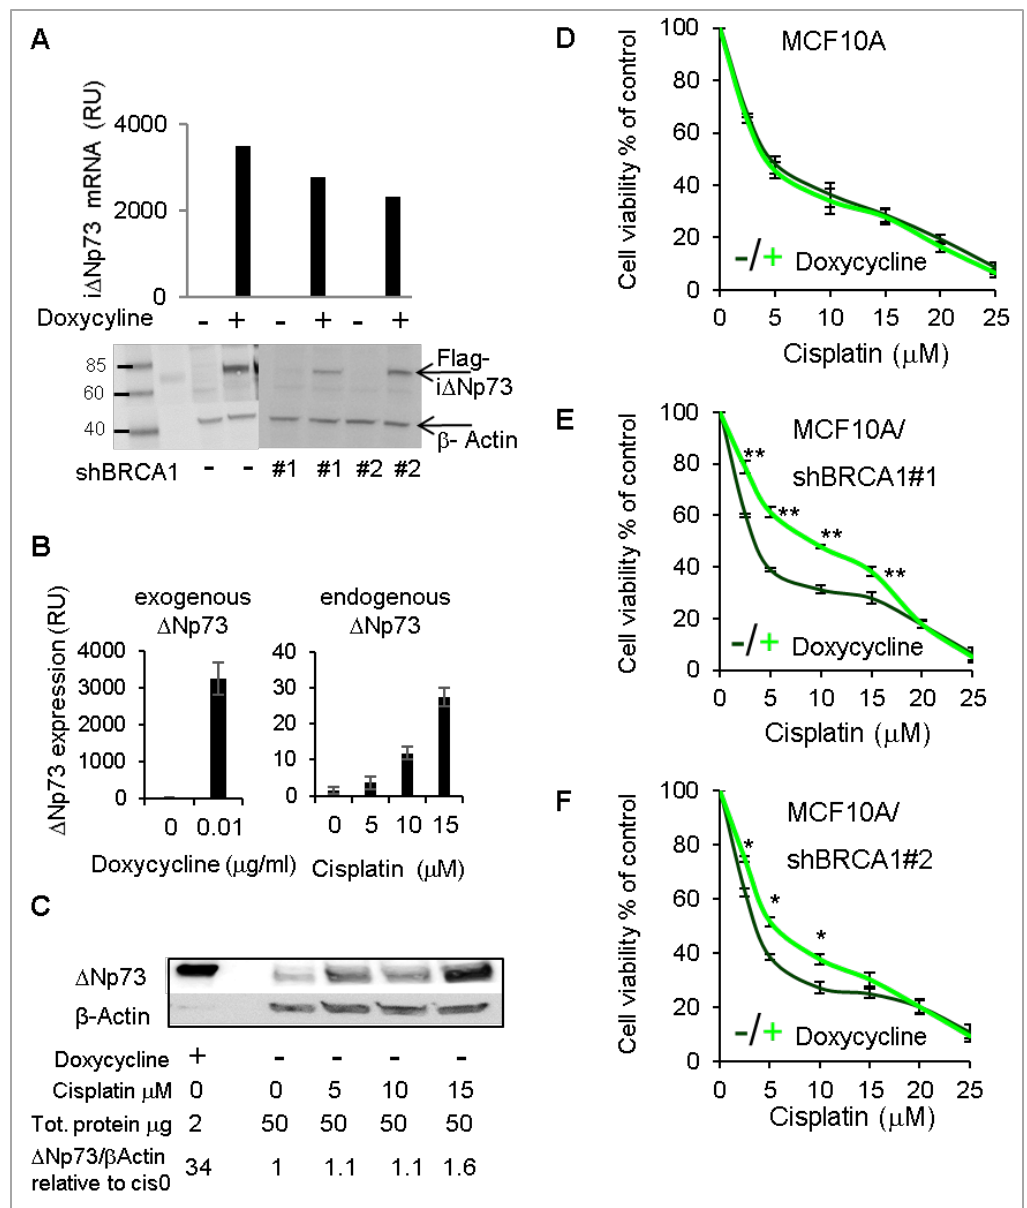
Figure 5. Over expression of deltaNp73 protected BRCA1-KD MCF10A from cisplatin-induced cell death, while the BRCA1-wt MCF10A were unaffected. Exogenous Flag-deltaNp73 was stably expressed in MCF10A and in the BRCA1-KD clones under the control of a doxycycline-inducible promoter. ( A ) Induction of flag-deltaNp73 (i D Np73) by 0.01 μg/mL doxycycline for 24 h is shown by mRNA (RT-qPCR) and protein (Western blot using Flag antibodies). Corresponding expression of BRCA1 in these clones is shown in Supplementary Figure S5a. ( B , C ) Comparison of i D Np73 mRNA and protein induced in MCF10A by 0.01 μg/mL doxycycline for 24 h to the endogenous deltaNp73 induced by cisplatin in the same cells. The data were quantified by ImageJ software and deltaNp73 values were normalized beta-Actin and calculated as relative folds of deltaNp73 in the untreated MCF10A (no doxycycline, no cisplatin). ( D–F ) MCF10A shown in ( A ) were exposed to 10 ng/mL doxycycline (or not), and simultaneously treated with increasing doses of cisplatin for 48 h. Cell viability was measured by XTT. Data represent the mean ± S.E.M of three independent experiments. Each experiment was done in triplicate. p -values were calculated by paired, 2-tail Student’s t-test, for each concentration of cisplatin separately. Stars are indicative of p -values: * p < 0.05, ** p < 0.01.